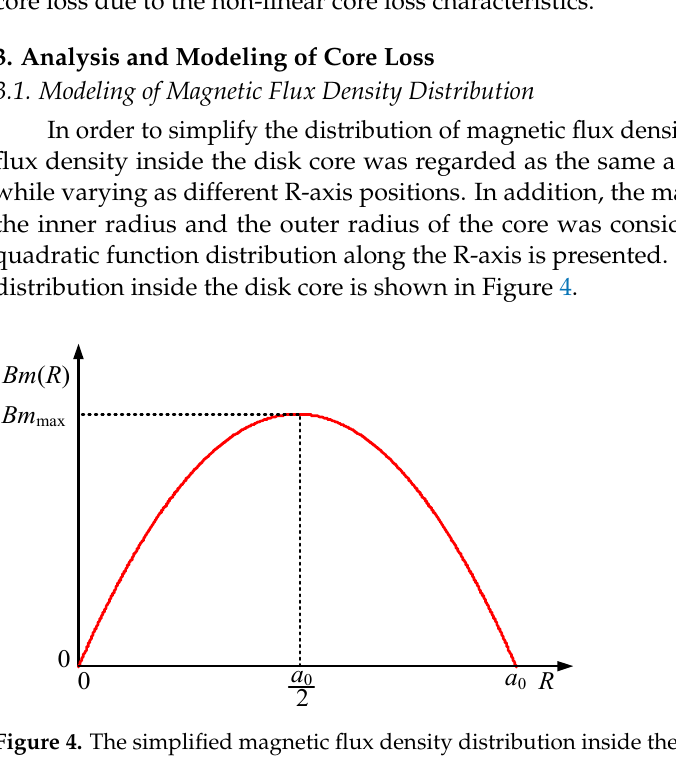
Figure 4. The simplified magnetic flux density distribution inside the disk core.